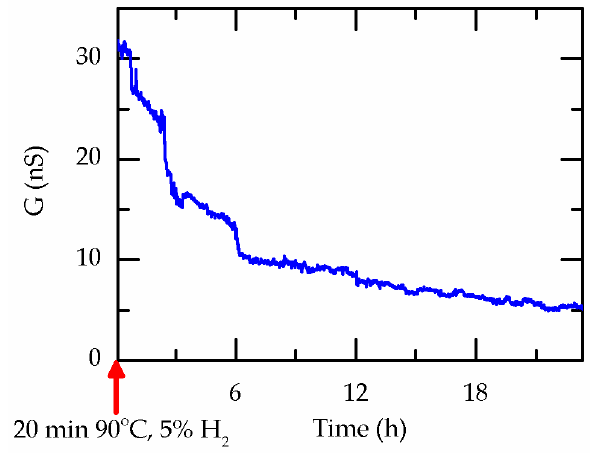
Figure 5. Single electron transistor (Pt ‐ Al 2 O 3 ‐ Pt) conductance at room temperature for an O 3 ‐ based device as a function of time immediately after an anneal in forming gas. The decrease in conductance is most likely caused by reoxidation near the edge of the tunnel barrier (Figure 6).